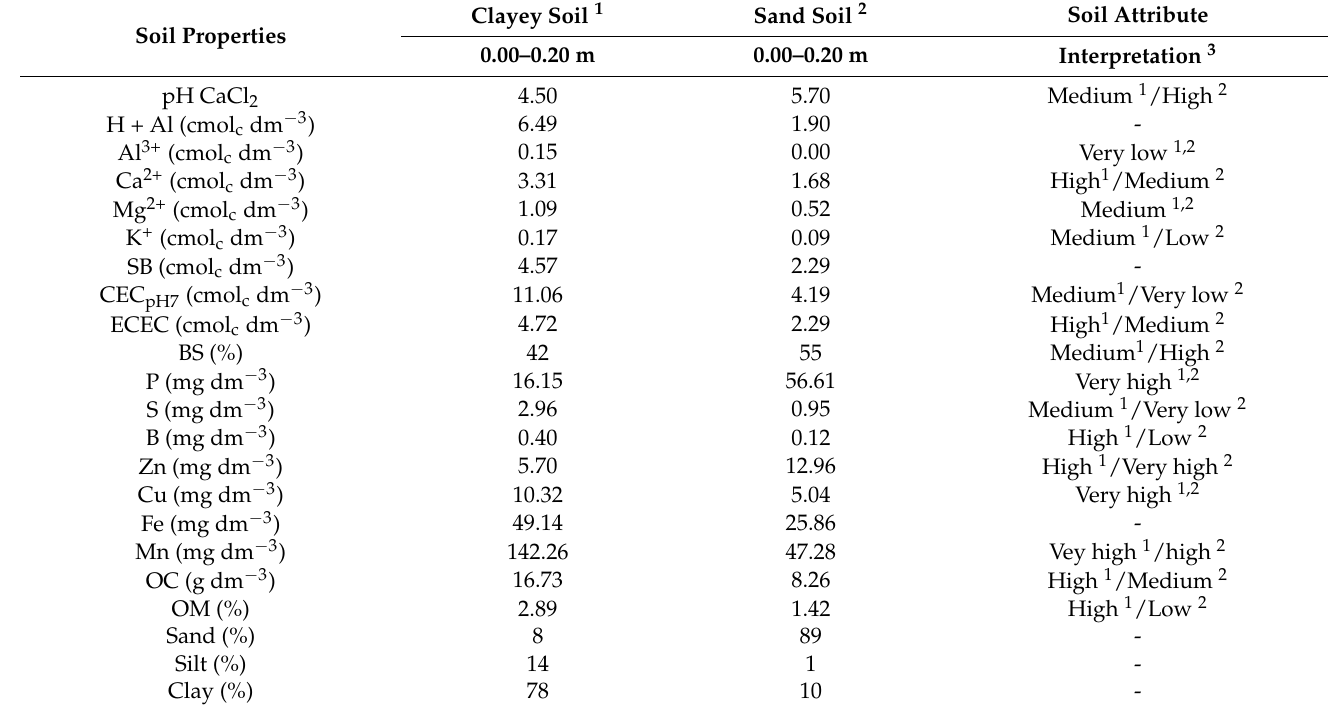
Table 1. Chemical and granulometric analysis of an Oxisol (clayey texture), Ultisol (sand texture) and interpretation of values for the surface layer (0.00–0.20